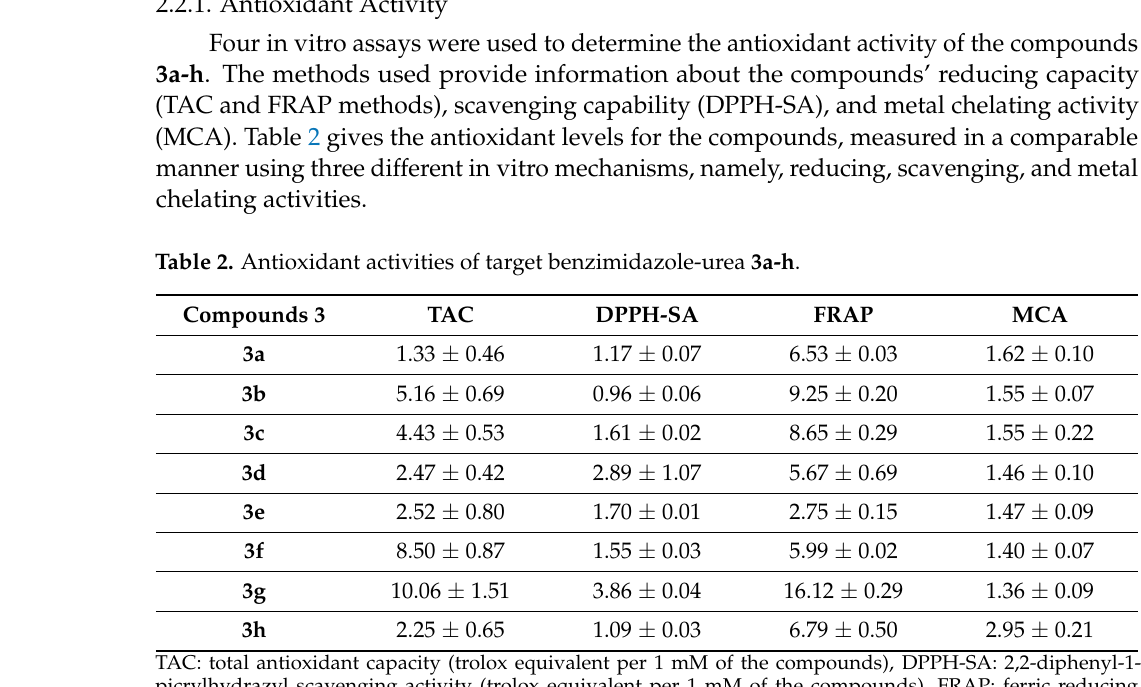
Table 2 . Antioxidant activities of target benzimidazole-urea 3a-h .